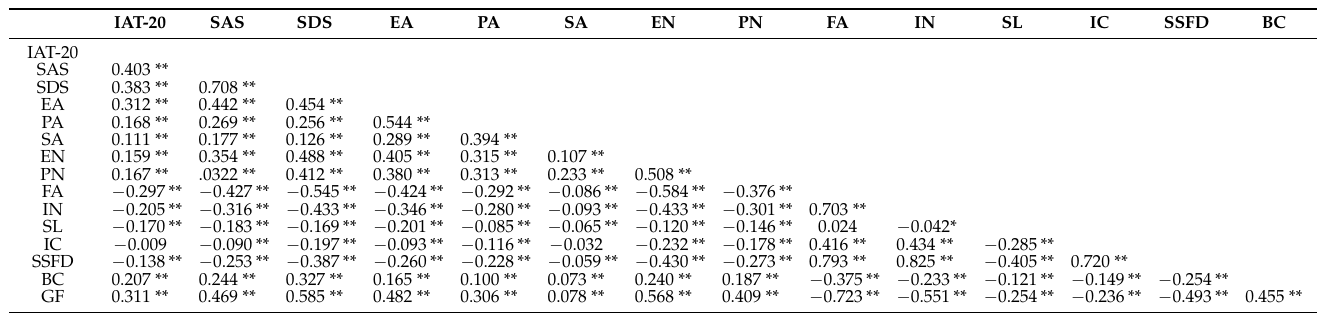
Table 2. Correlation analysis between the total scores of IAT-20 and SAS, SDS, CTQ-28, SSFD, and